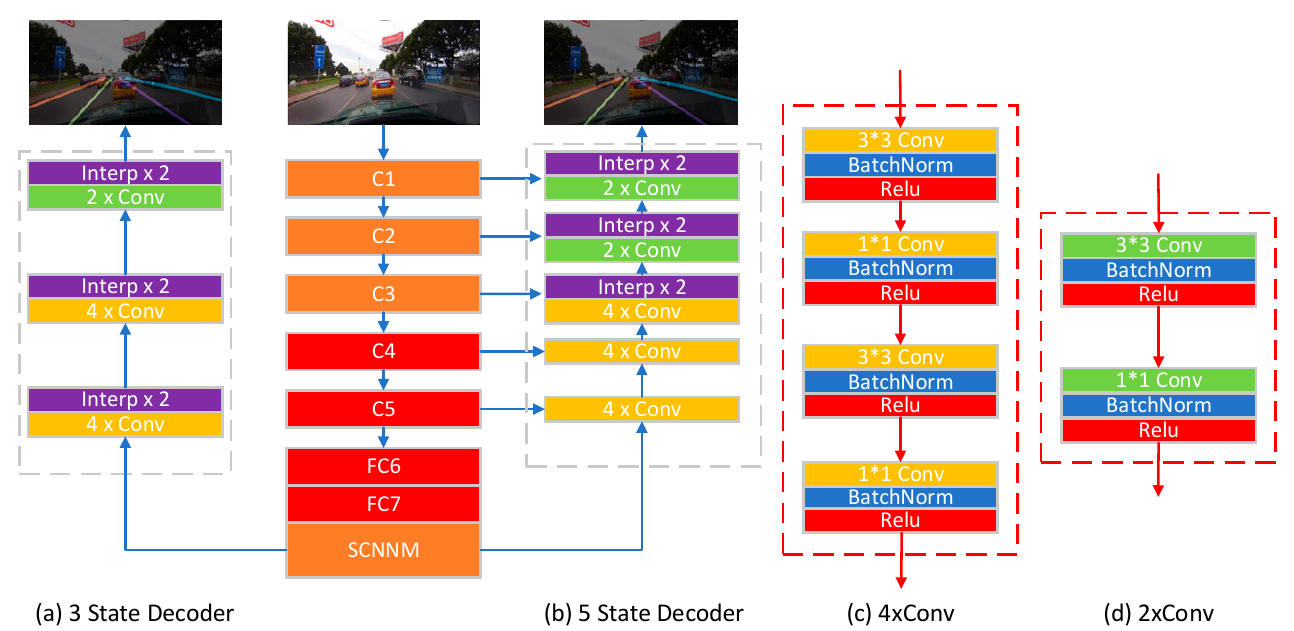
Figure 3. Block diagram of decoder structure of target feature distillation network.